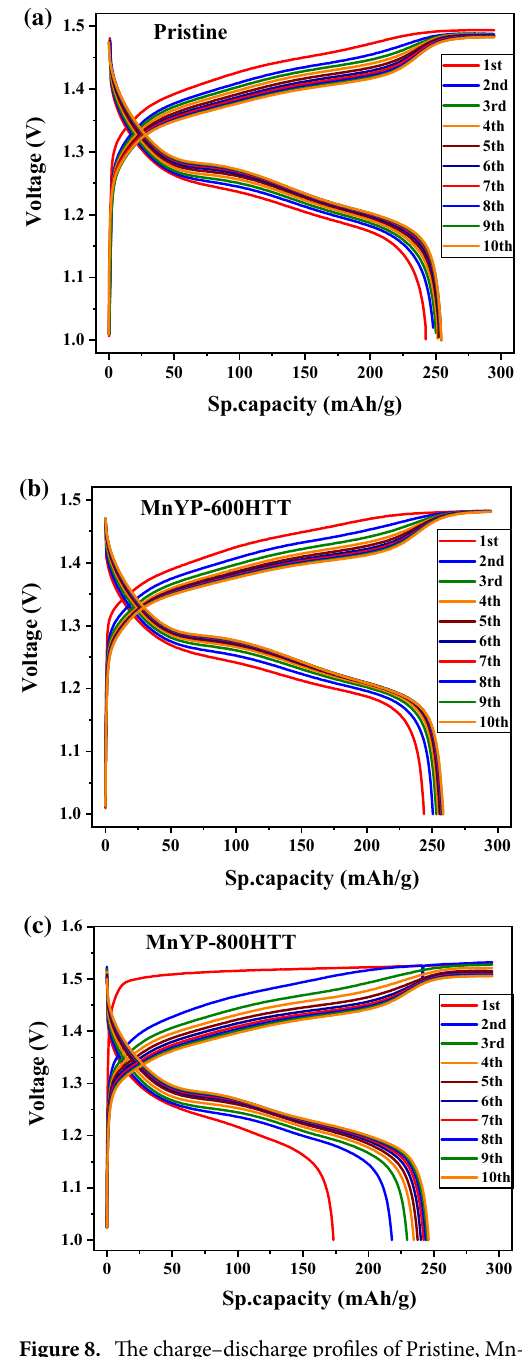
Figure 8. The charge–discharge profiles of Pristine, Mn-doped MnYP-600HTT,